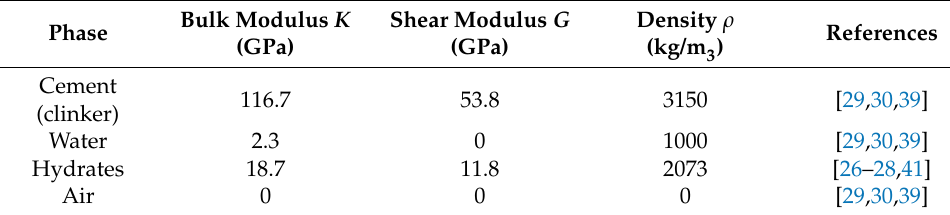
Table 1. Physical parameters of different phases for cement